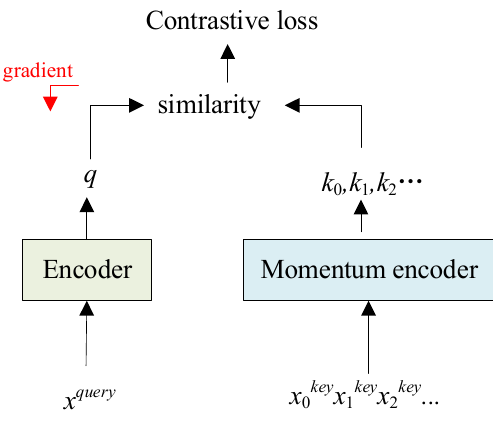
Figure 1. The update process of MOCO.